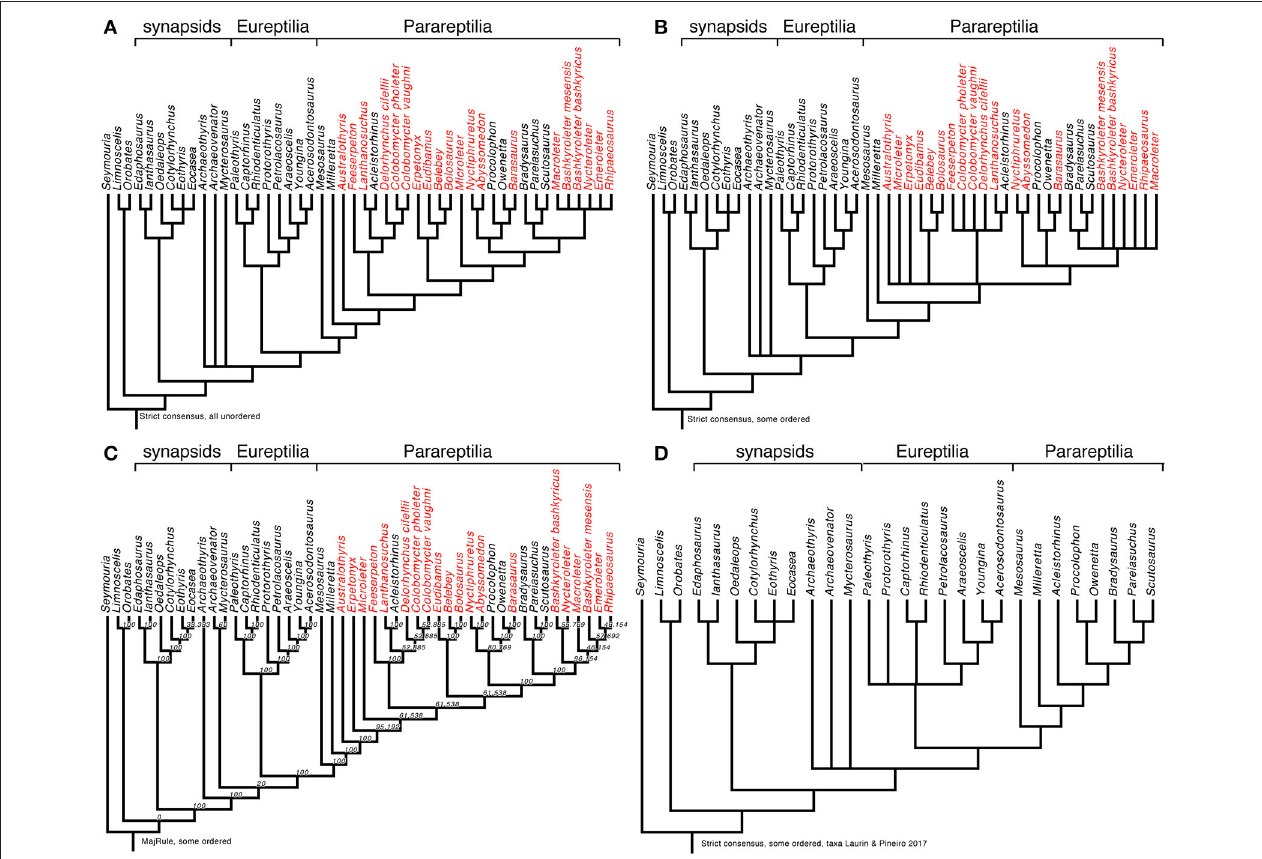
FIGURE 2 | Early amniote phylogeny as assessed through various reanalyses of a slightly modified version of the matrix of MacDougall et al. (2018). (A) Strict consensus obtained by reanalyzing the data matrix without any modifications. This is basically identical with the tree obtained by MacDougall et al. (2018, Figure 1A), but it is reproduced here to facilitate comparisons among the results obtained in our various analyses. (B) Strict consensus obtained by reanalyzing the data matrix after ordering characters 6, 47, 48, 52, 69, 89, 105, 129, 132, 147, 150, 165, 167, 168, 178. Note that in some cases, the order of the states had to be altered to reflect the nature of the morphocline. (C) Majority-rule consensus tree (nodal values represent frequencies in the source trees) from the same analysis. (D) Strict consensus tree from analysis of the same matrix, except that taxa not represented in Laurin and Piñeiro (2017) were removed before analyzing the data. This refutes the claim that the topology obtained by Laurin and Piñeiro (2017) results from exclusion of several parareptile taxa (in red on parts A–C ) that were considered by MacDougall et al. (2018), because exclusion of these taxa from the matrix of MacDougall et al. (2018) does not change the